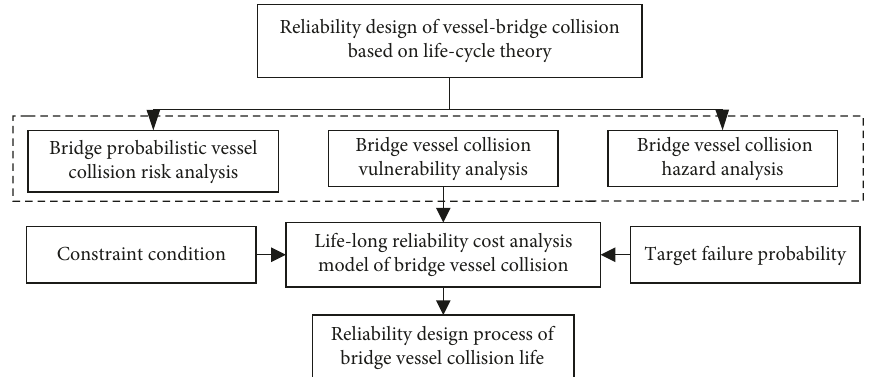
Figure 1: The theoretical framework of vessel-bridge collision life-cycle reliability